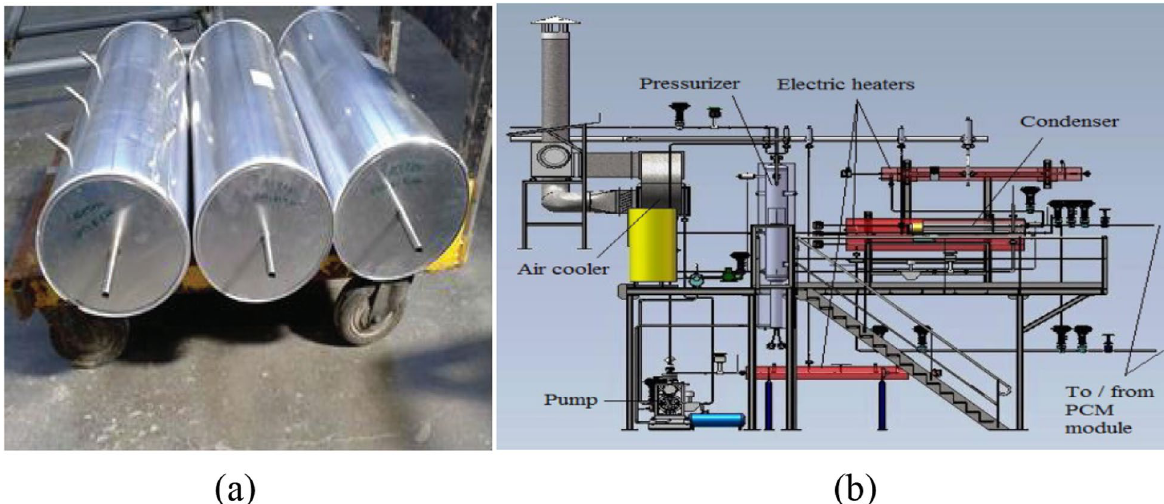
Fig. 4 Representative configurations and application of LHS based on inorganic salt PCMs: a “shell and tube” configuration for CSP plants and b the thermal energy storage module for CSP plants [109,